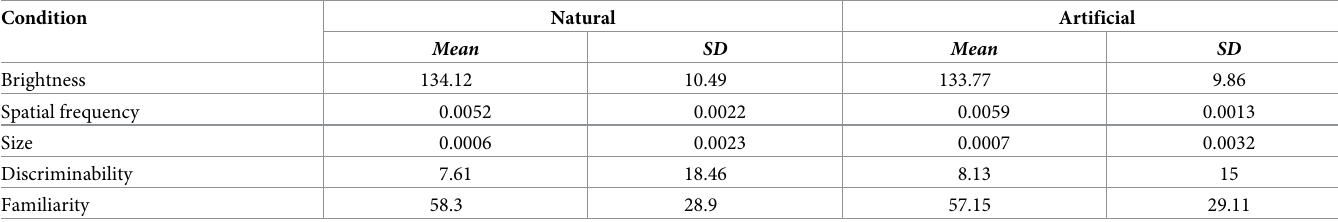
Table 2. Visual properties and evaluative ratings of stimuli for each